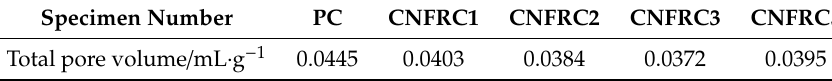
Table 2. Total pore volume of each specimen.